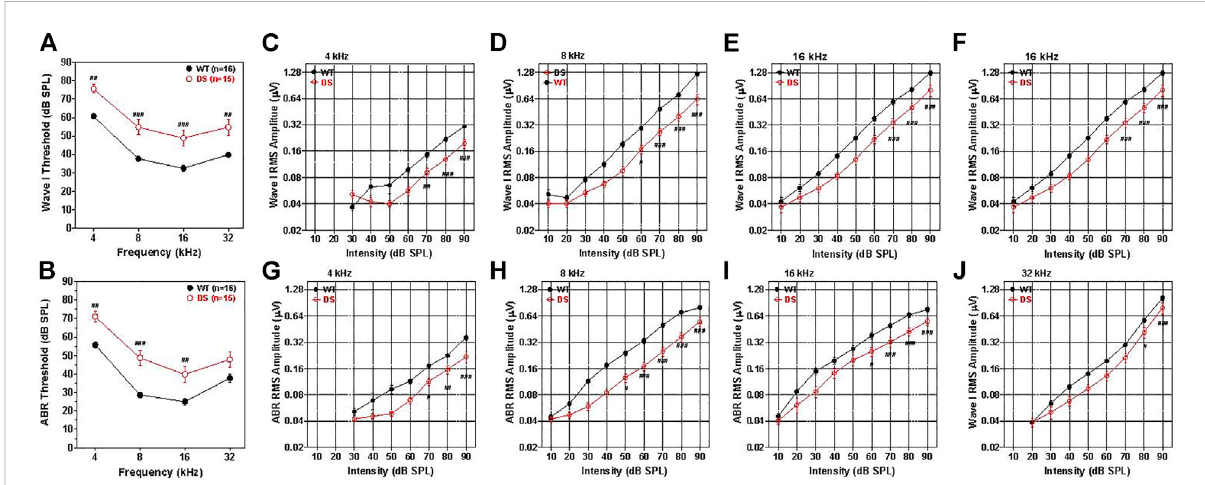
FIGURE 4 Wave I and ABR thresholds are15 – 20 dB higher in DSmice than WT mice. (A) Mean (+/ − SEM) waveI thresholds versusfrequency inDS ( n = 15) andWT( n =16)mice. WaveIthresholds signi fi cantly higherinDSthanWTmiceat4,8,16,and32 kHz (B) Mean(+/ − SEM)ABRthresholdsinDSmice ( n = 15) signi fi cantly higher than WT mice at 4, 8, and 16 kHz ( ### p < 0.001, ## p < 0.01). Wave I and ABR amplitudes are smaller in DS than WT mice. (C – F) Mean WT ( n = 16, +/ − SEM) and DS (+/ − SEM, n = 15) wave I RMS amplitude (log base 2 scale) versus intensity functions at 4, 8, 16, and 32 kHz. (G – J) Mean WT( n =16,+/ − SEM)andDS(+/ − SEM, n =15)ABRRMSamplitude(logbase2scale)versusintensity at4,8,16,and32 kHz.Two way repeated measure analysis of variance. Signi fi cant differences between DS and WT mice indicated in each panel: # p < 0.05, ## p < 0.01, ### p <